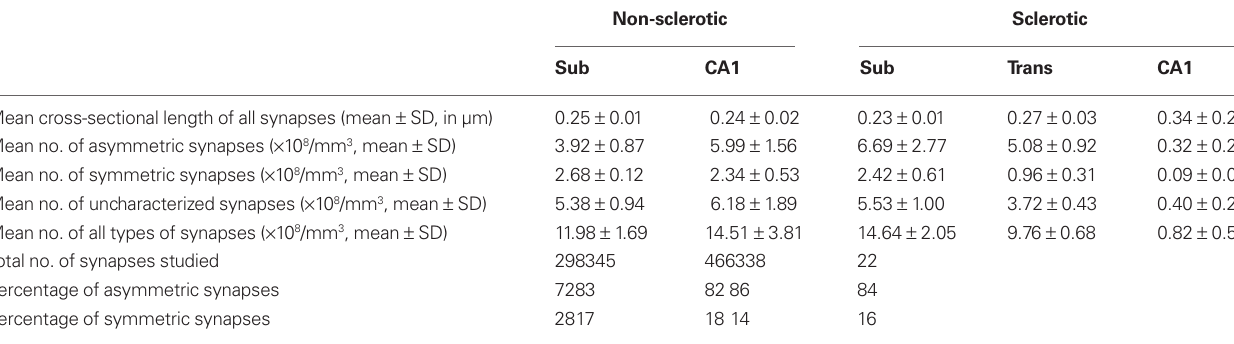
Table 2 | Accumulated data from all the hippocampal regions studied. All synapses include asymmetric, symmetric and uncharacterized